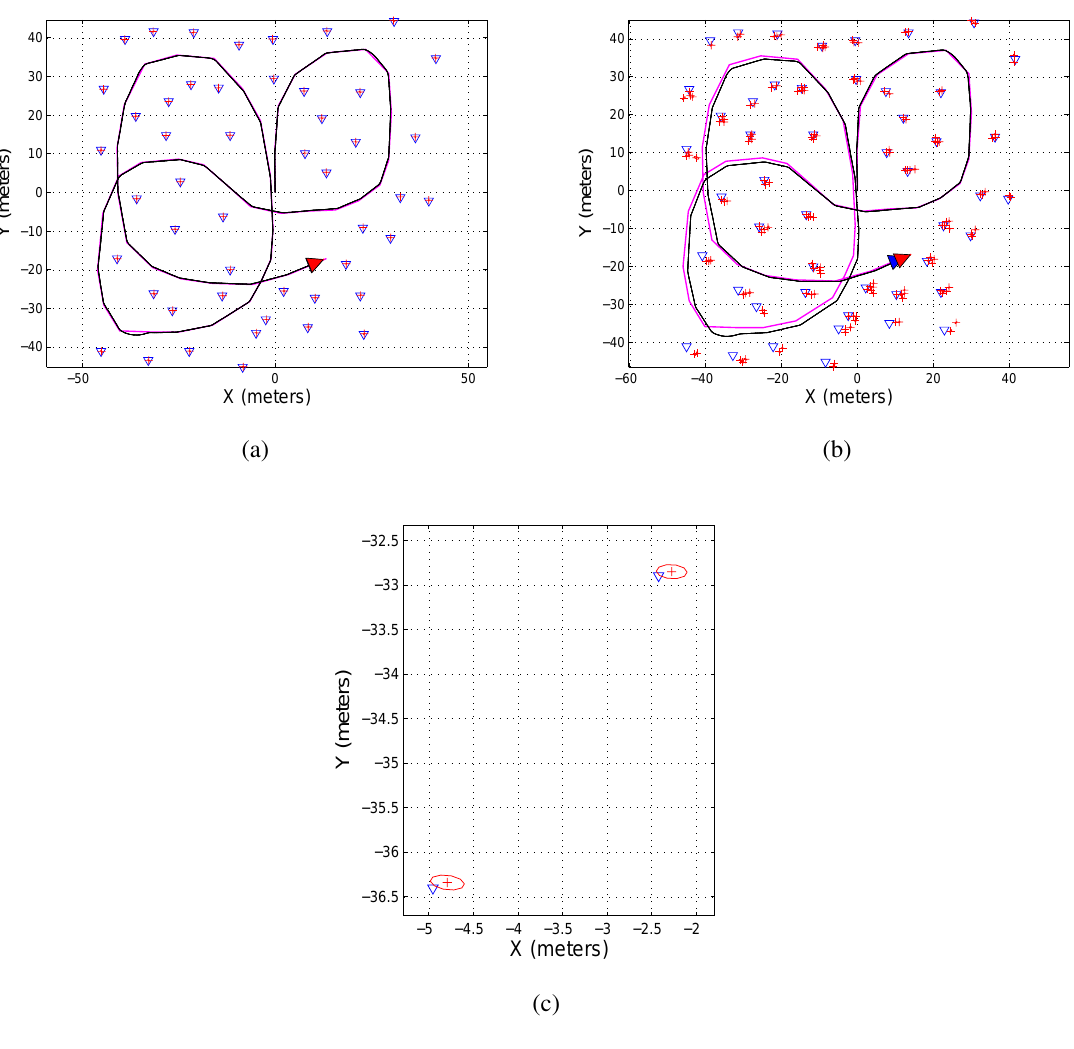
Map reconstruction using the sequential EKF-SLAM presented in Algorithm 1—without feature restriction. (a) Shows both: the map and the